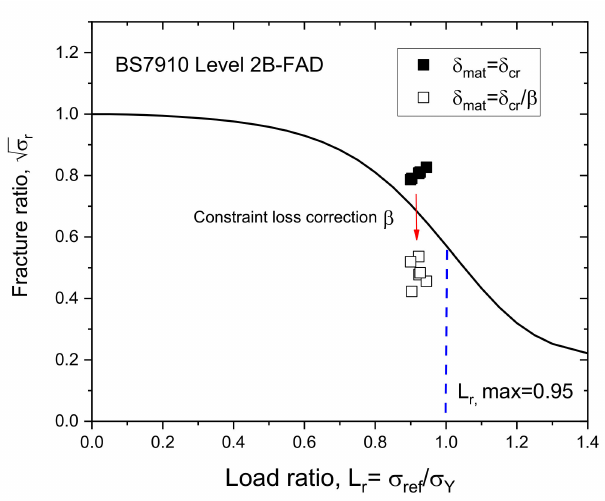
Figure 16. FAD estimation of 9% Ni steel with and without accounting for the equivalent CTOD